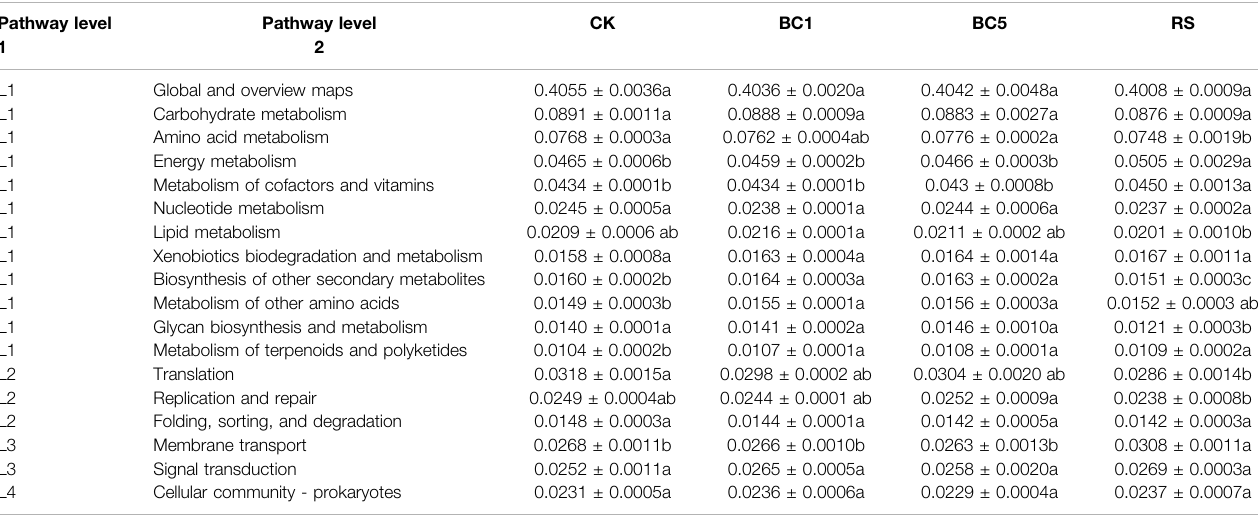
TABLE 4 | The relative abundance information of the secondary function of soil bacterial